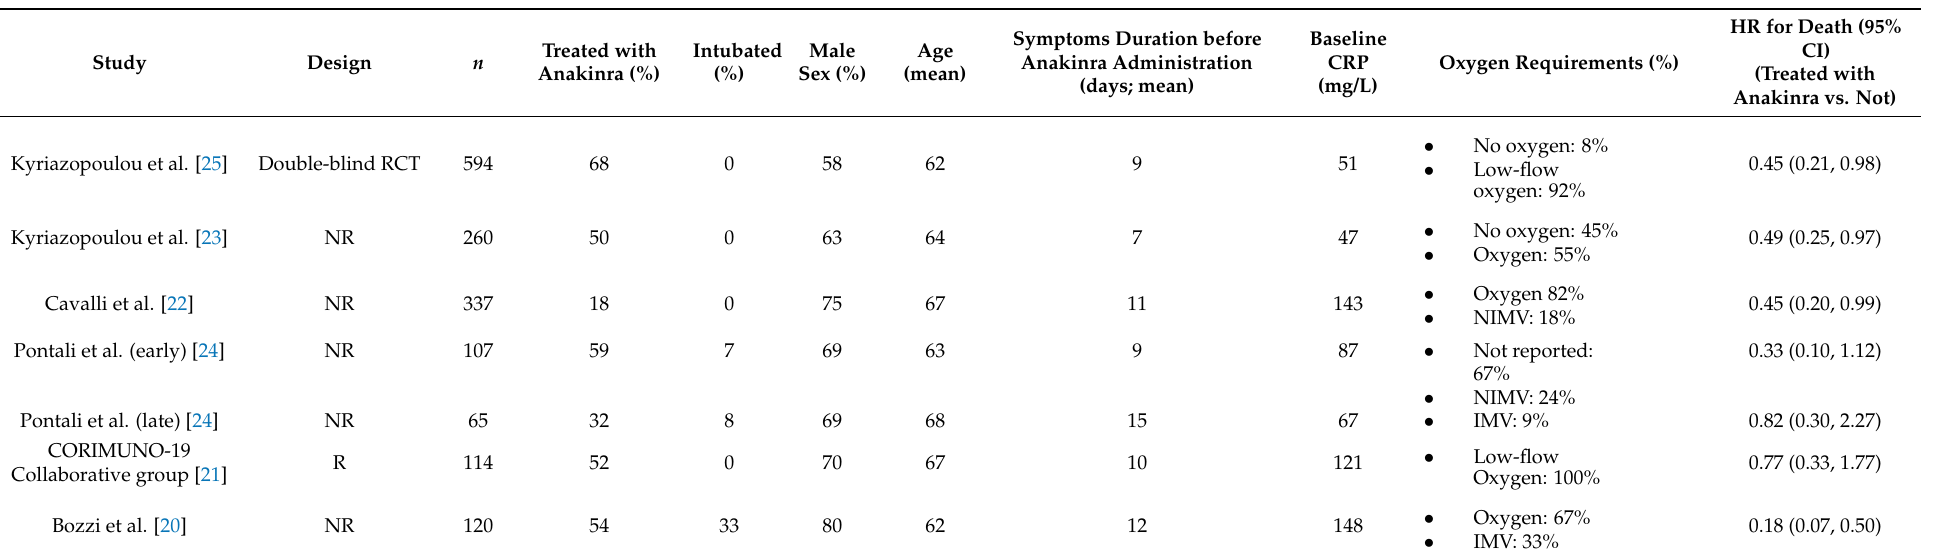
Table 1. Main characteristics and findings of included